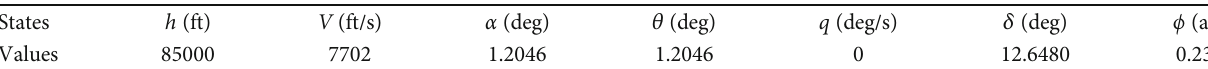
Table 3: Trimmed conditions of SM.